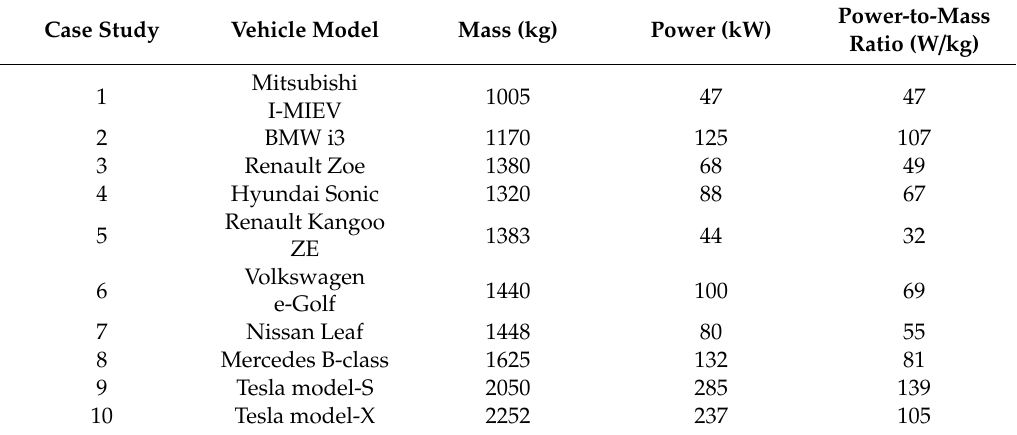
Table A1. Technical features of BEV models assumed as reference for the considered case